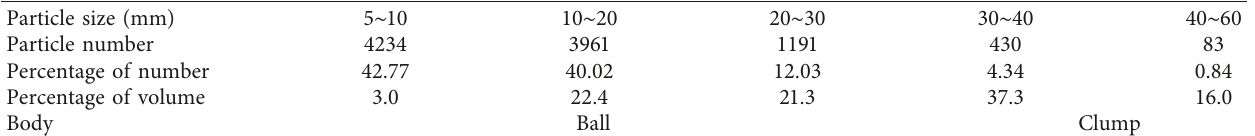
Figure 14: The relationship between the particle breakage index B s and interlocking strength: (a) interlocking strength versus principal stress ratio and (b) B 1 ∼ 2 s versus interlocking strength. Table 1: Number and shape of particles with different particle